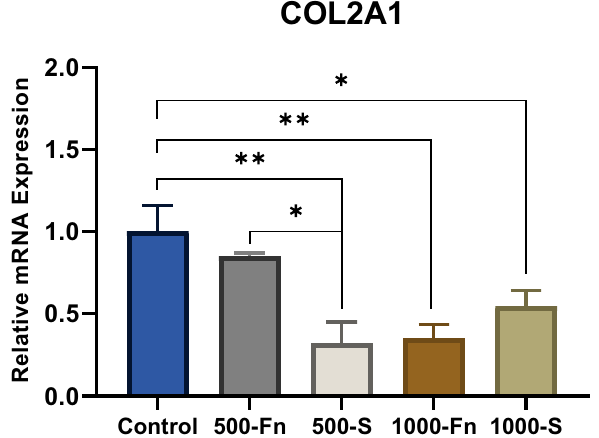
Figure 11. Relative COL2A1 mRNA expression of hWJ-MSCs grown on fibronectin and spidroin micropattern after 21 days of culture (Control = non-coated coverslip, 500-Fn = 500 µm fibronectin